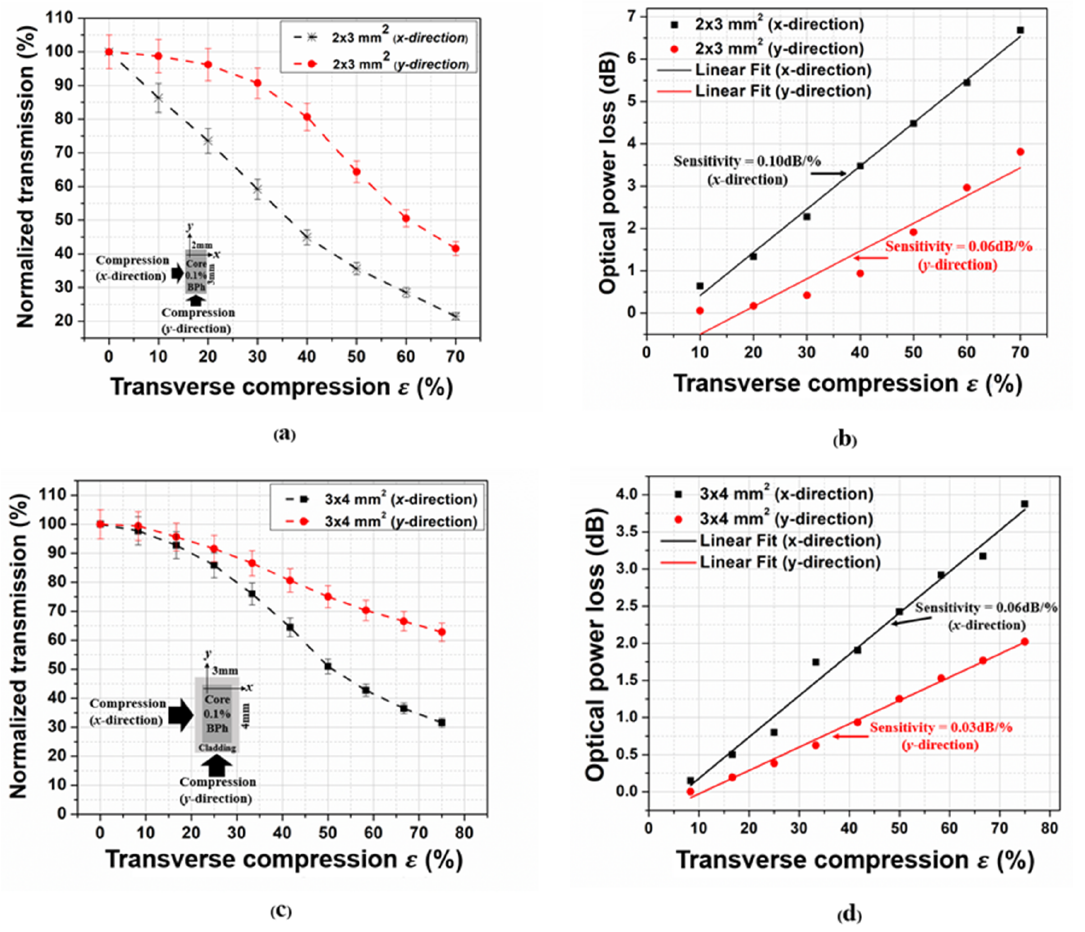
Figure 5. Waveguide (0.1 % BPh/wt.) sensitivity measurement: normalized transmission as a function of transverse compression and the relationship between the optical power loss as a function of the transverse compression, ( a , b ): 2 × 3 mm 2 , core/air-clad; ( c , d ): 3 × 4 mm 2 , core/cladding.